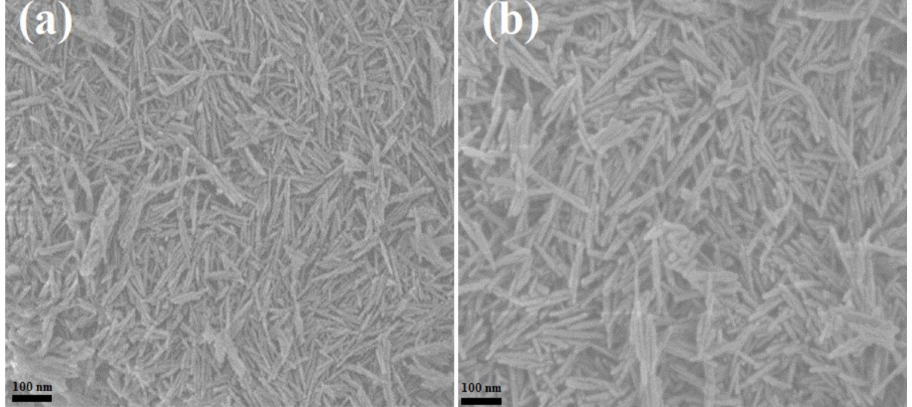
Figure 2. SEM images of ( a ) n-Al 2 O 3 and ( b ) 3% CuZnO/n-Al 2 O 3 .